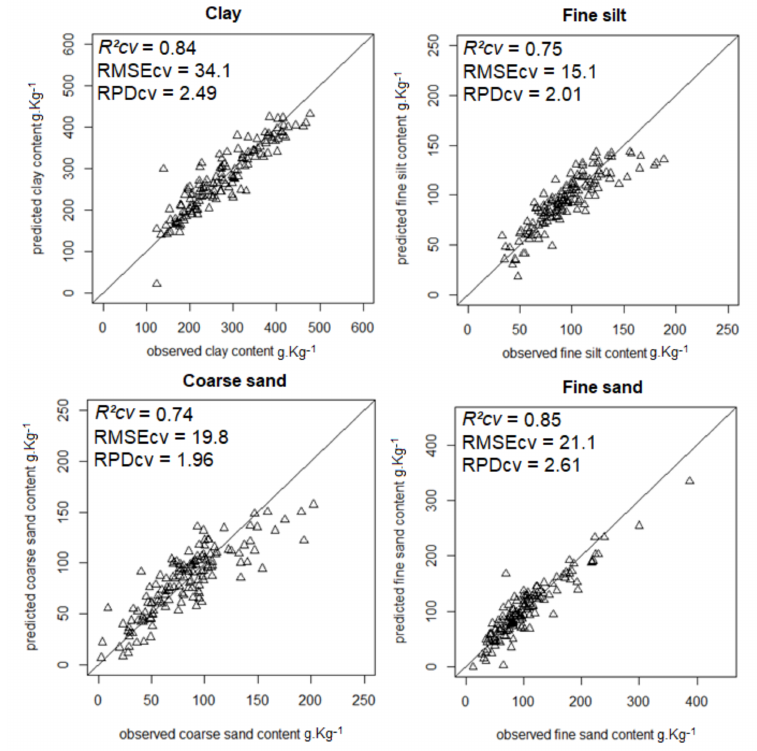
Figure 2. Scatterplots of predicted vs. observed clay, fine silt, coarse, and fine sand contents from model averaging.